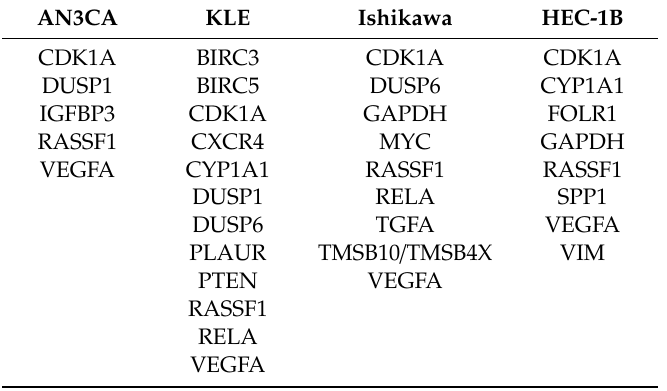
Table 3. DETA / NO regulated genes in endometrial cancer